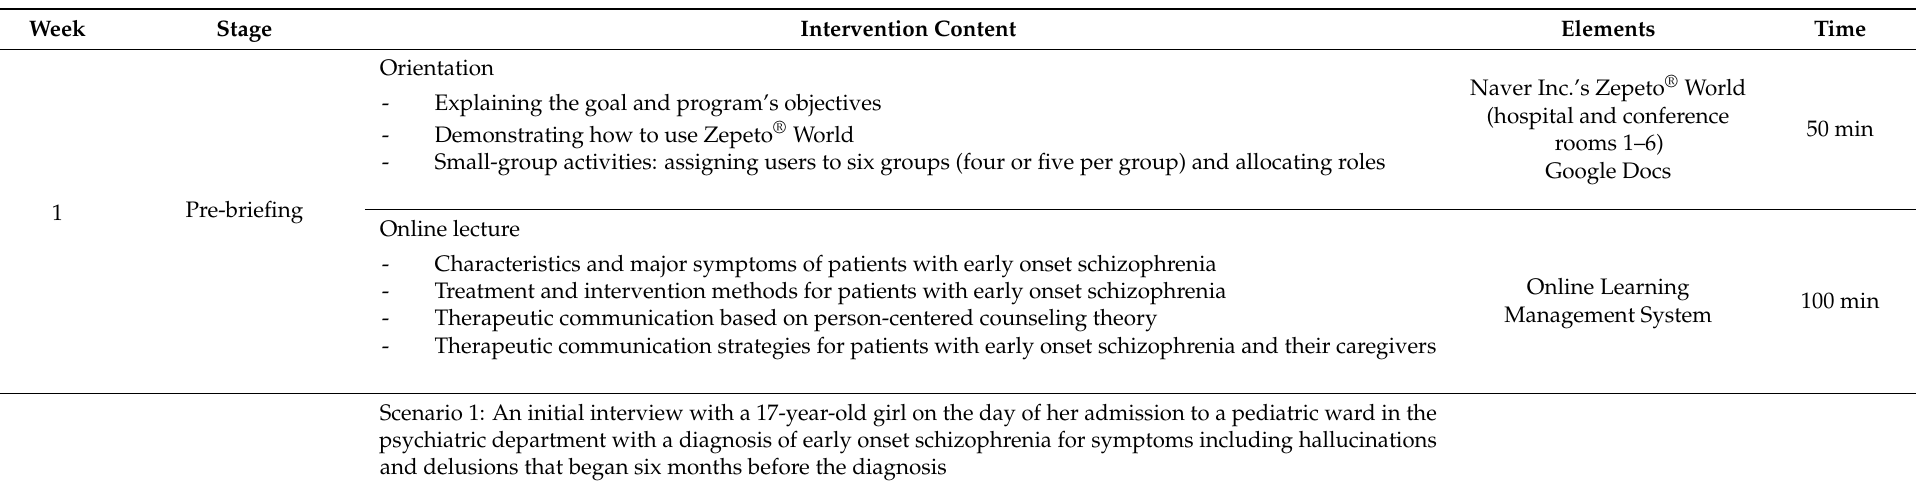
Table 2. Contents of a multi-access metaverse-based early onset schizophrenia nursing simulation program based on Raskin and Rogers’ [6] person-centered counseling